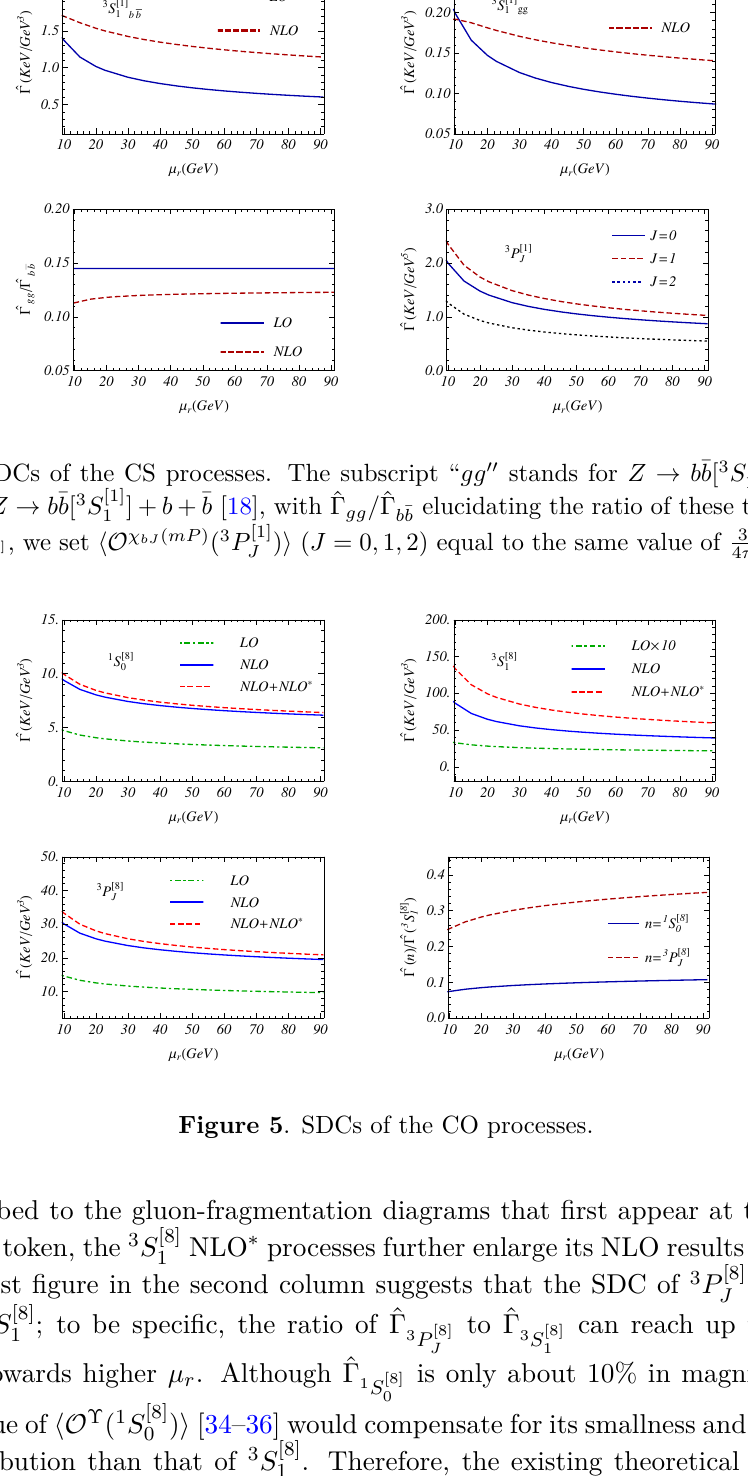
Figure 5 . SDCs of the CO